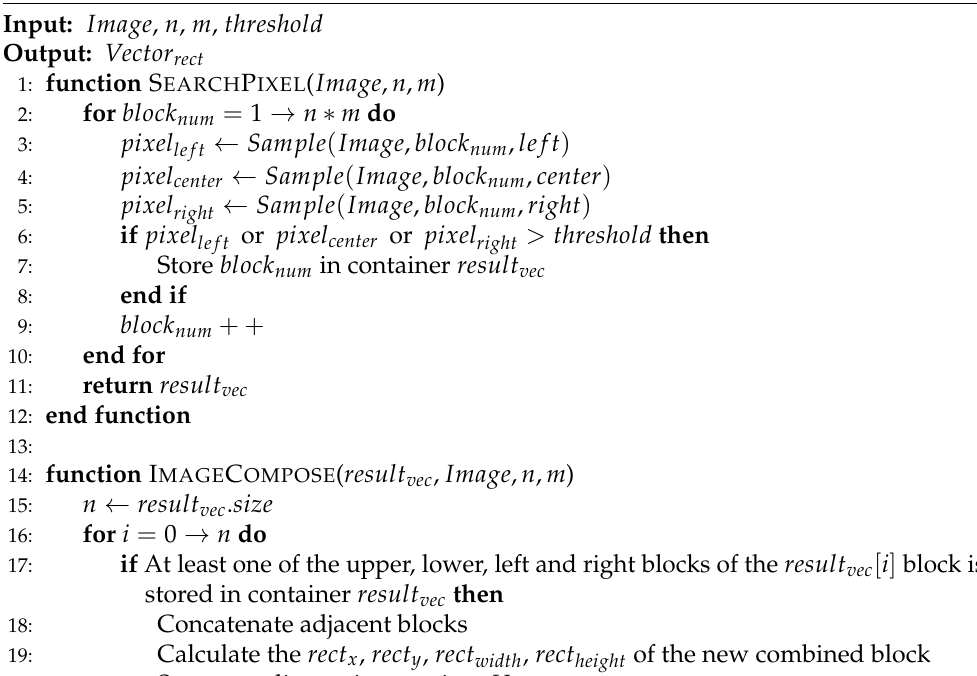
Algorithm 1 Grid virtual division